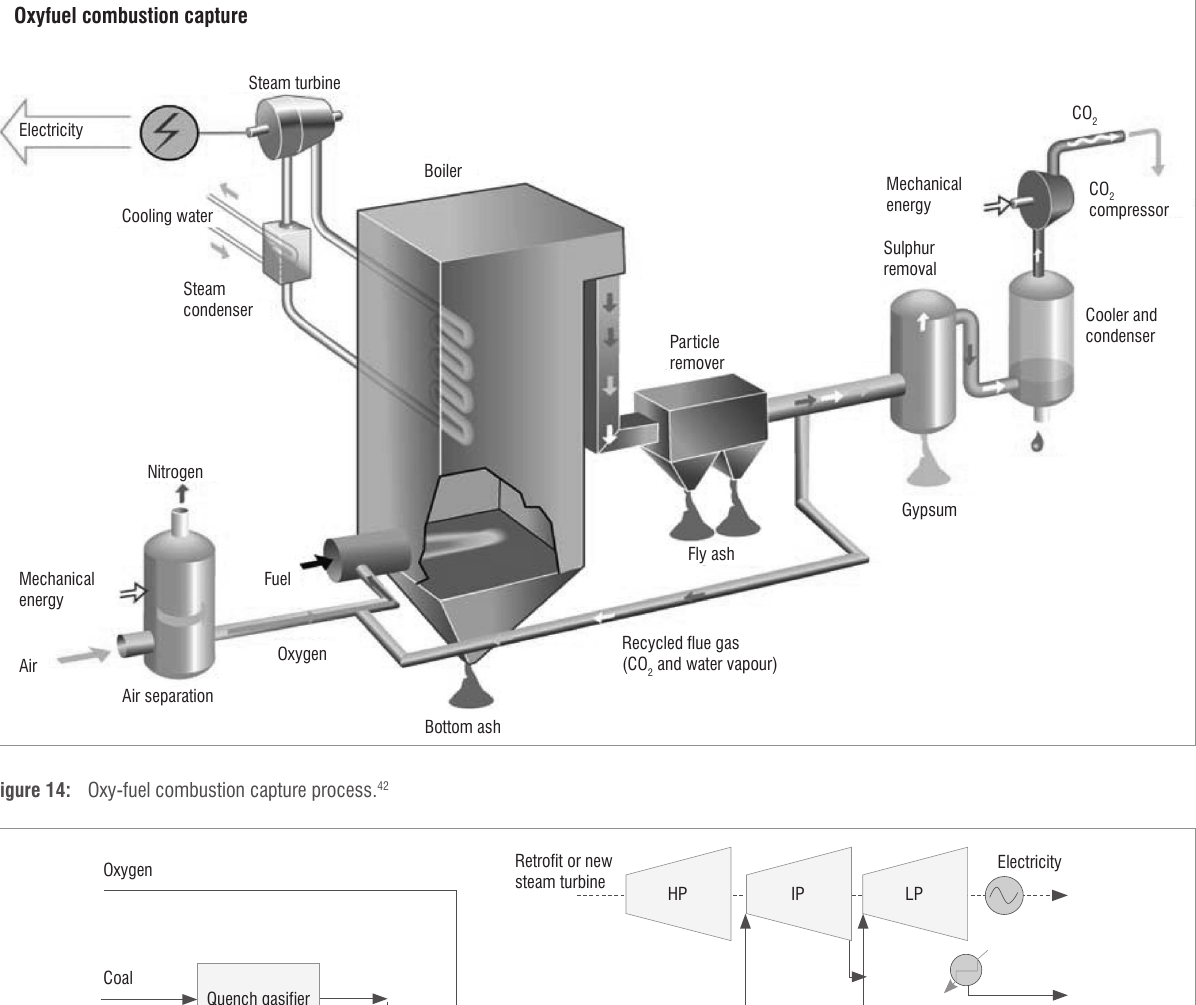
Figure 14: Oxy-fuel combustion capture process. 42